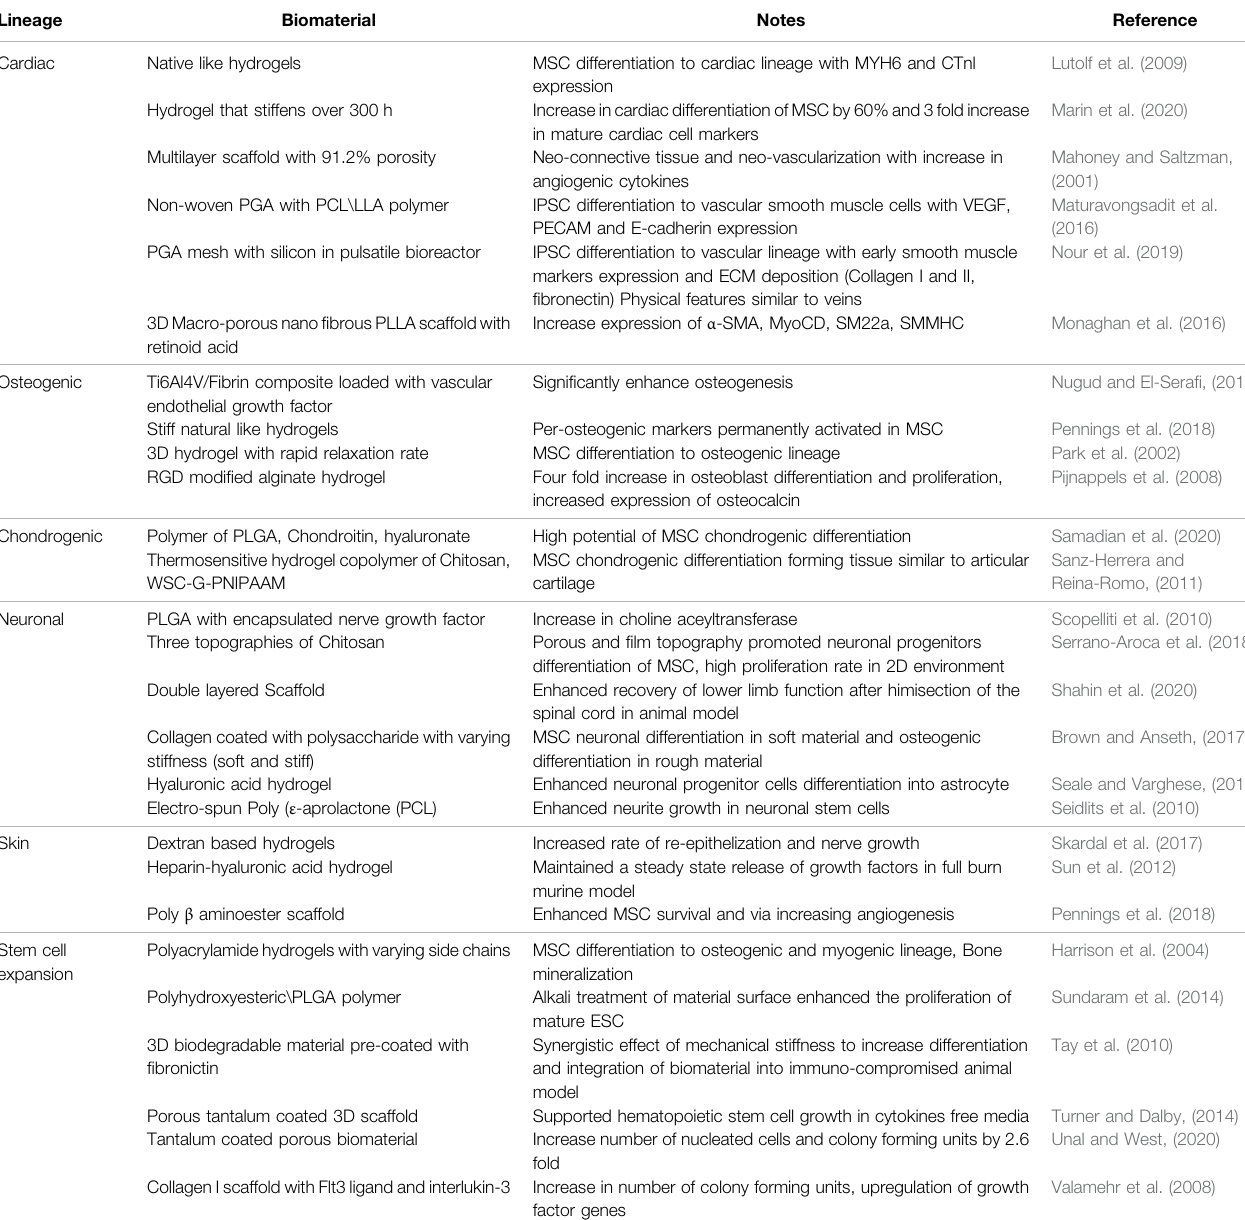
TABLE 1 | Examples of biomaterials used to promote stem cell expansion and